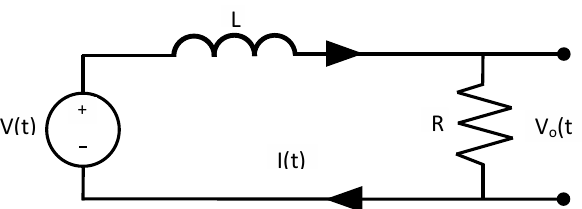
Figure 2. RL circuit used to obtain the first-order transfer function in electrical systems.